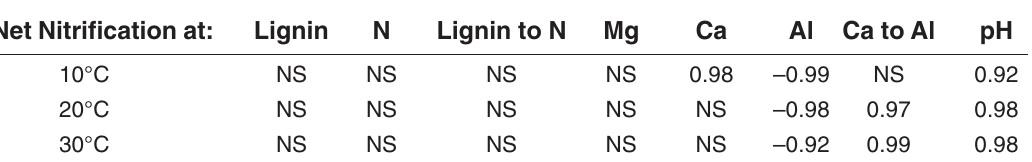
Linear (Pearson Product-Moment) Correlations of Forest Floor and Soil Variables with Net Nitrification at Three Incubation Temperatures (10, 20,